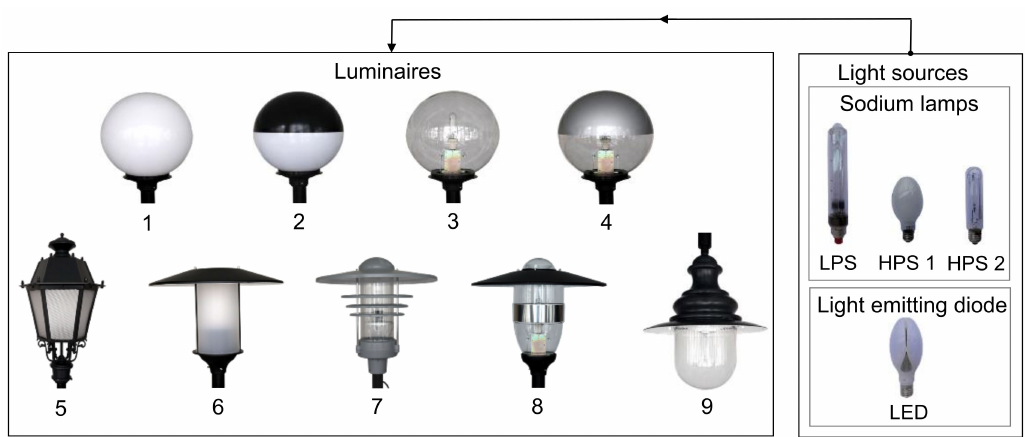
Figure 1. The photos of the luminaires considered together with the light sources analyzed.